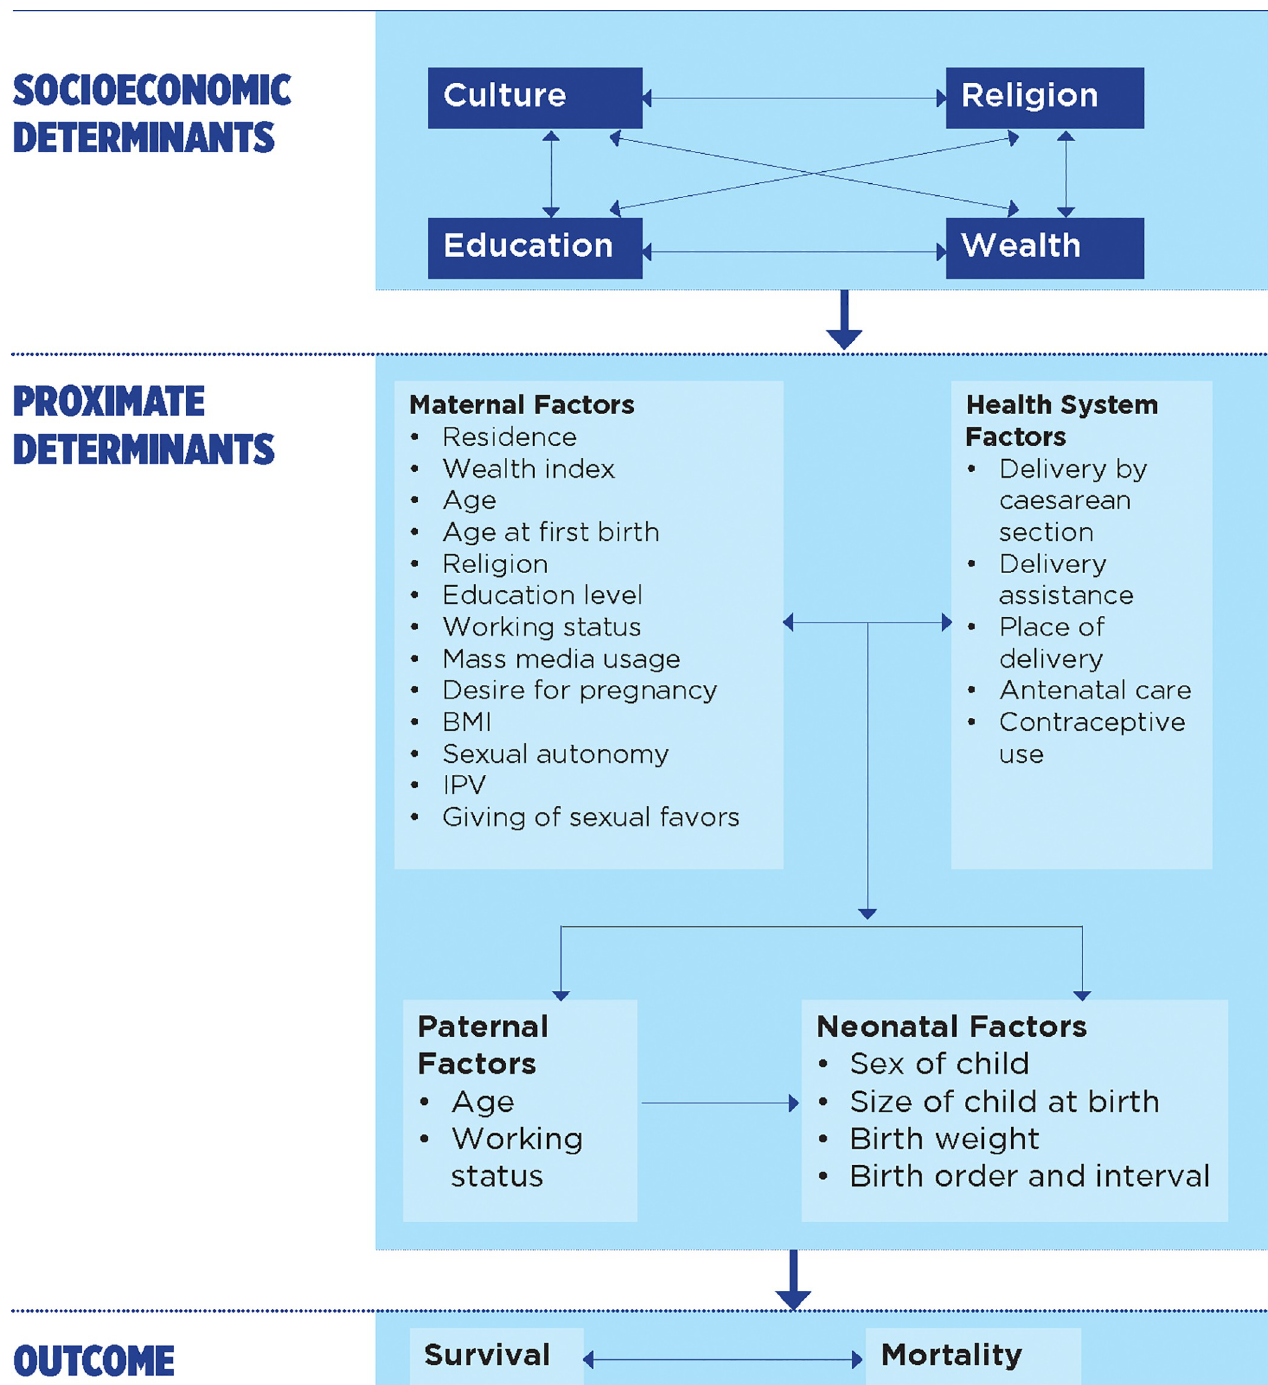
Fig 1. Conceptual